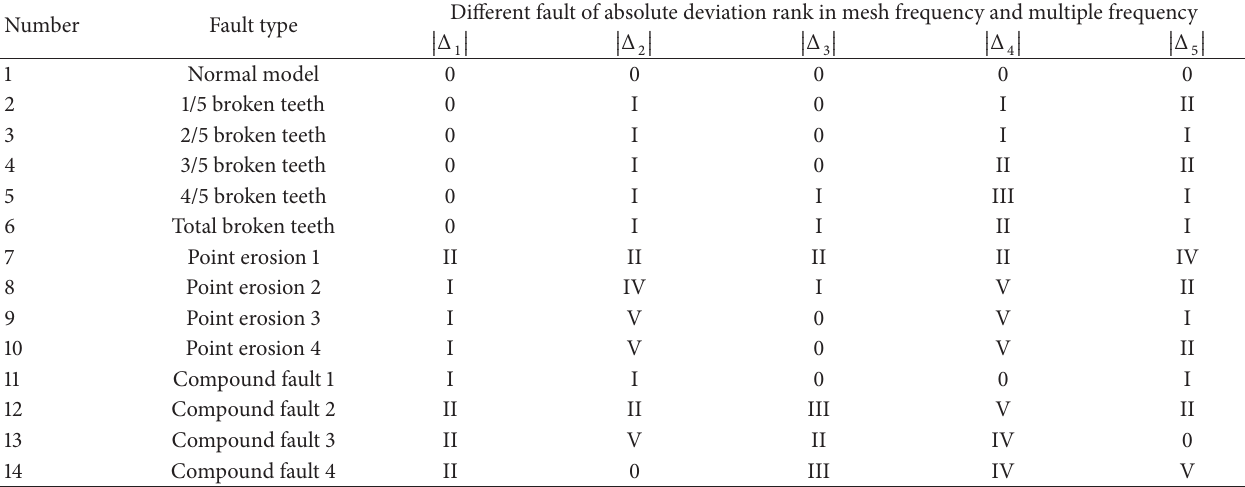
Table 6: The level of absolute deviation of different fault types vibration frequency